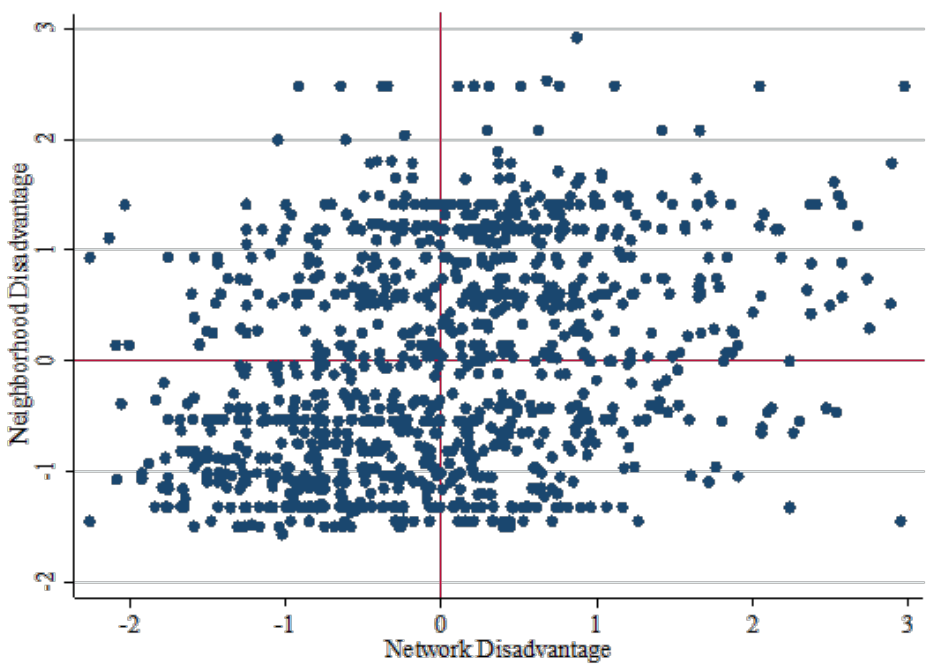
Figure 2: Distribution of respondents by standardized network and neighborhood disadvantage (N = 1,048). Higher numbers indicate more disadvantage. The middle of the plot, where the lines cross, finds the means of the two standardized measures (0, 0). The figure displays respondents who experience both above average network and neighborhood disadvantage (N = 316); who experience below average network disadvantage but above average neighborhood disadvantage (N = 180); who experience both below average network and neighborhood disadvantage (N = 365); and who have above average network disadvantage but below average neighborhood disadvantage (N = 187).